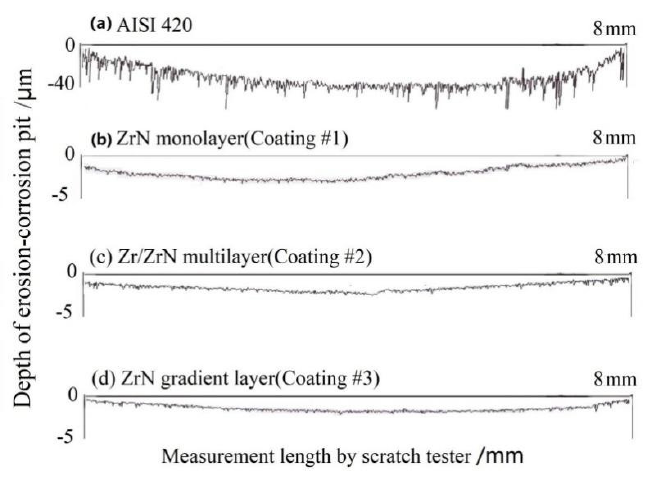
Figure 12. Surface profiles and curves of pits of samples after slurry erosion-corrosion tests.